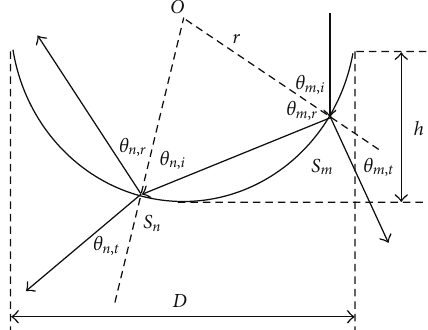
Figure 2: Schematic depicting a cross-section of a spherical cap, and the associated variables, used to model the etch pits of an acidic- textured